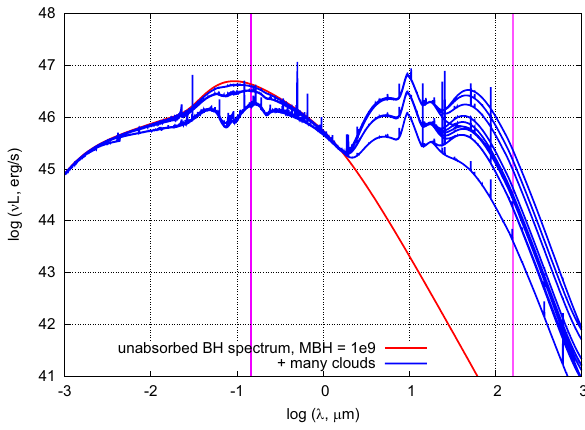
Figure 2: Examples of spectra for the models of SMBH with absorption by small clouds. The unabsorbed spectrum of SMBH is presented in Figure 1 by red line. The SMBH mass is set to